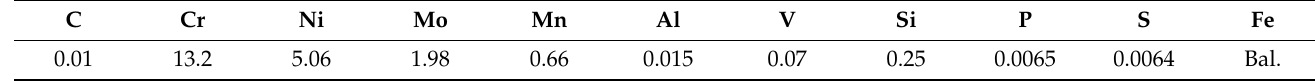
Table 1. Chemical composition of SMSS (wt.%).